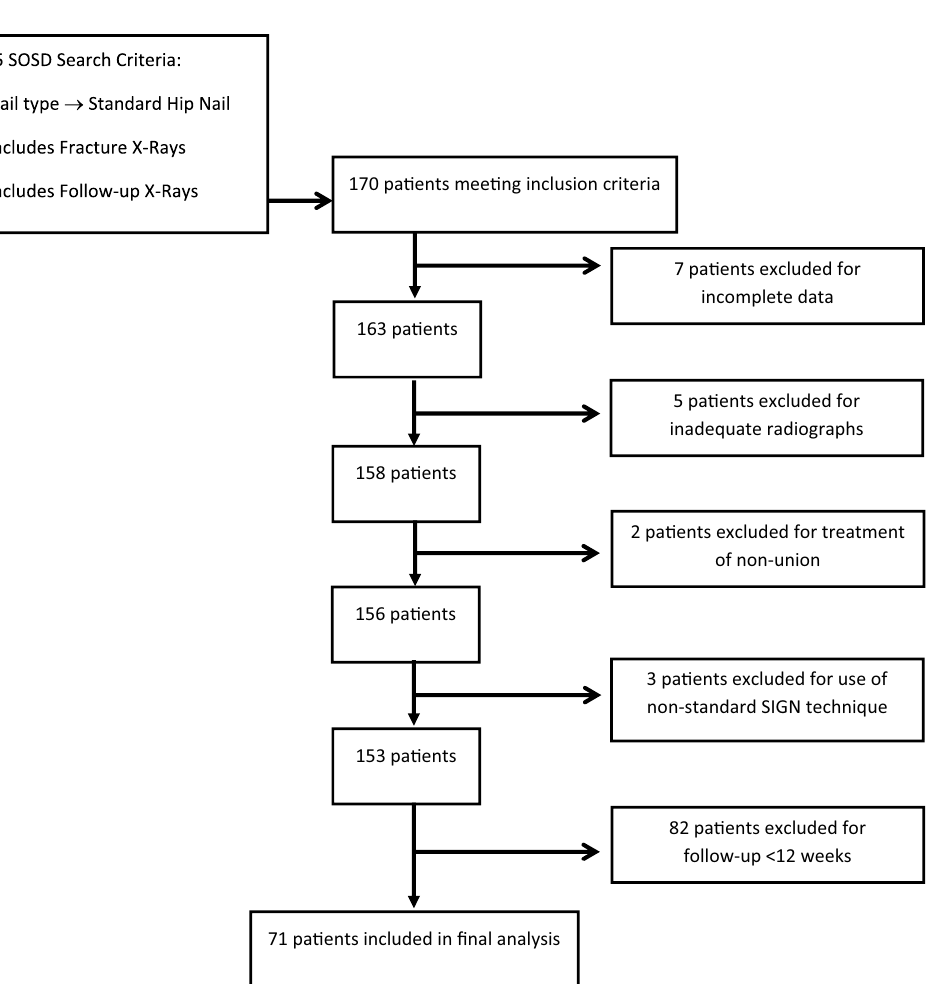
Figure 2. Patient selection fl